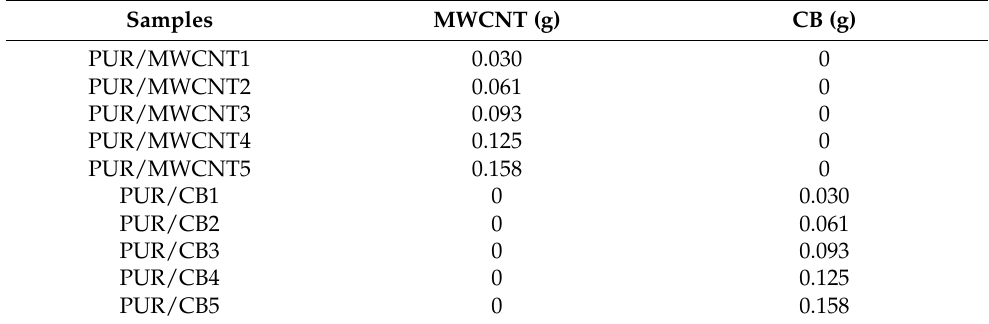
Table 1. Masses of MWCNT and CB to produce PUR/CB and PUR/MWCNT nanocomposites (in 3.0 g of